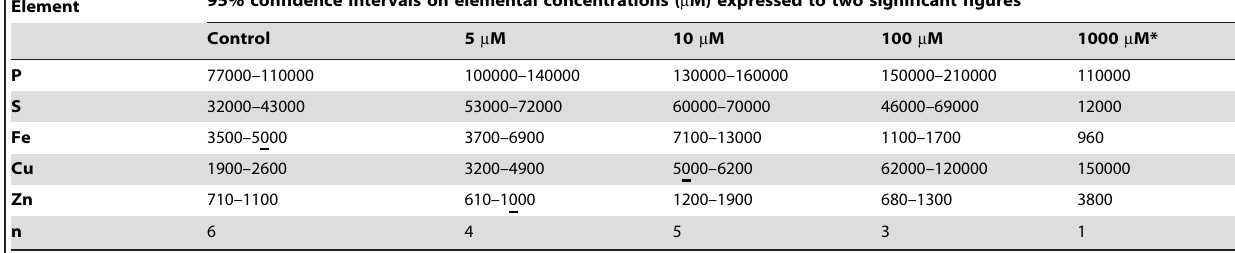
Table 1. Elemental profiles in exponential phase N. europaea cultures exposed to different Cu(II) doses.